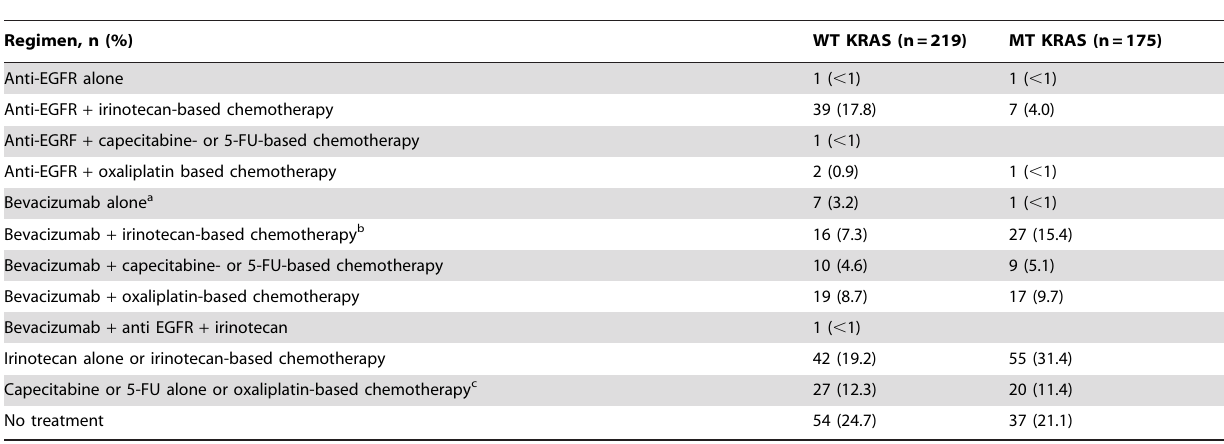
Table 2. Subsequent therapy according to tumour KRAS status.